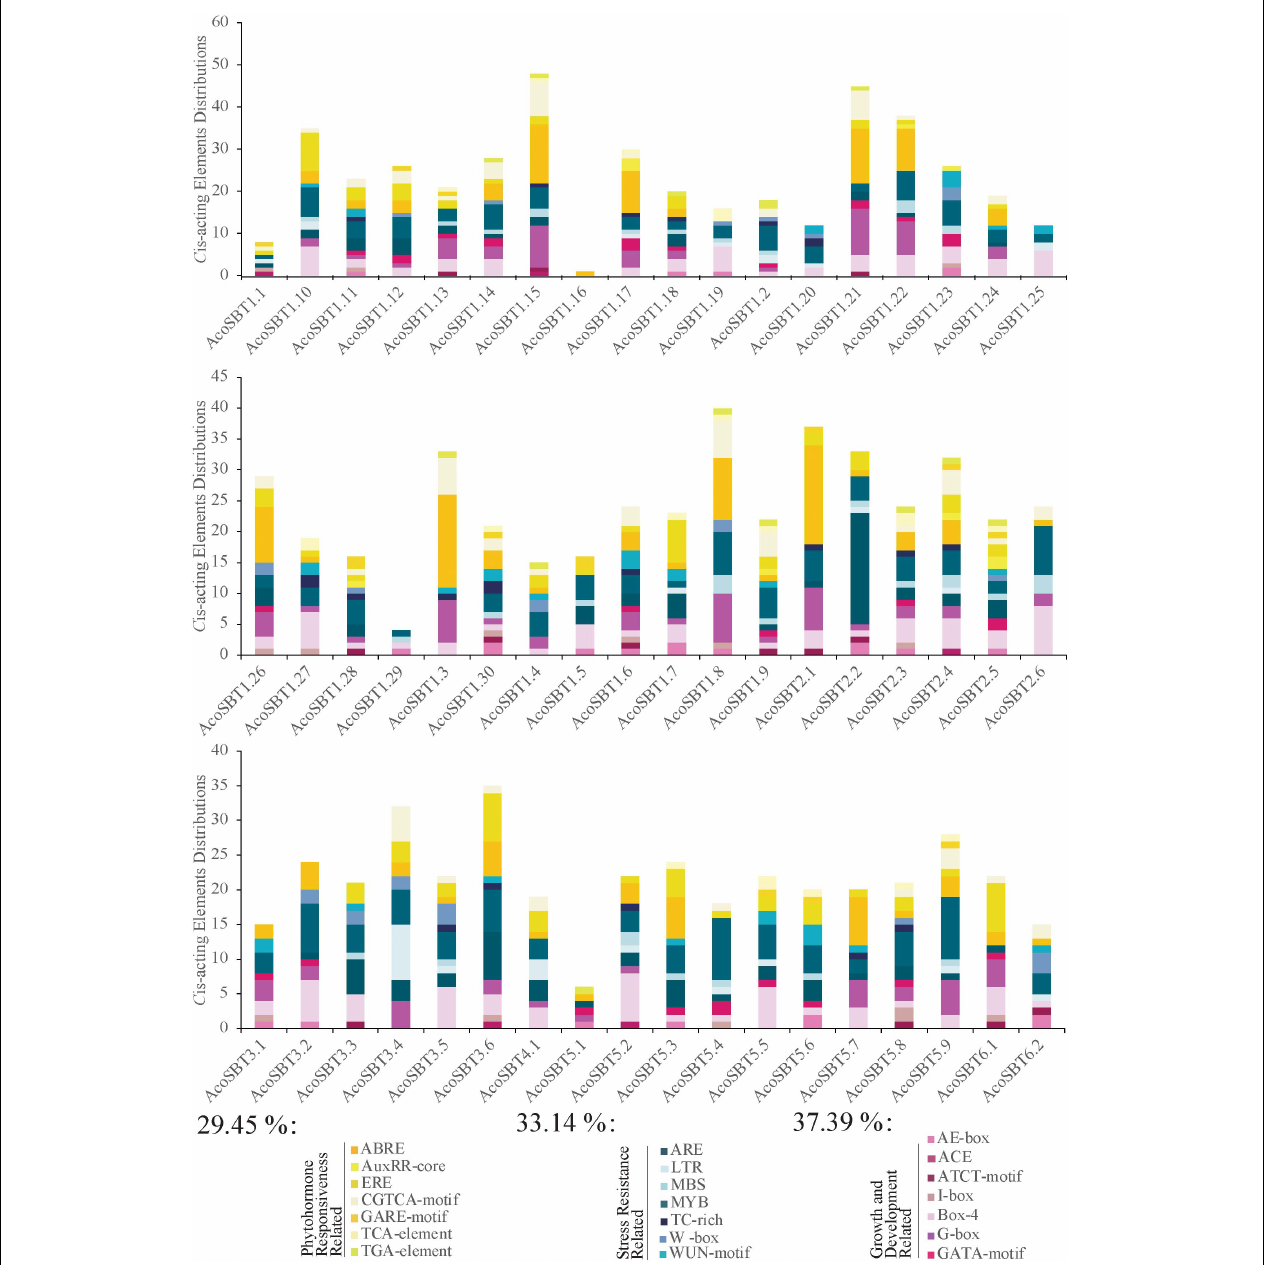
FIGURE 5 | Information of Cis -acting elements in promoter region AcoSBT genes. Distribution, classification and proportion of Cis -acting elements in the promoter region of each